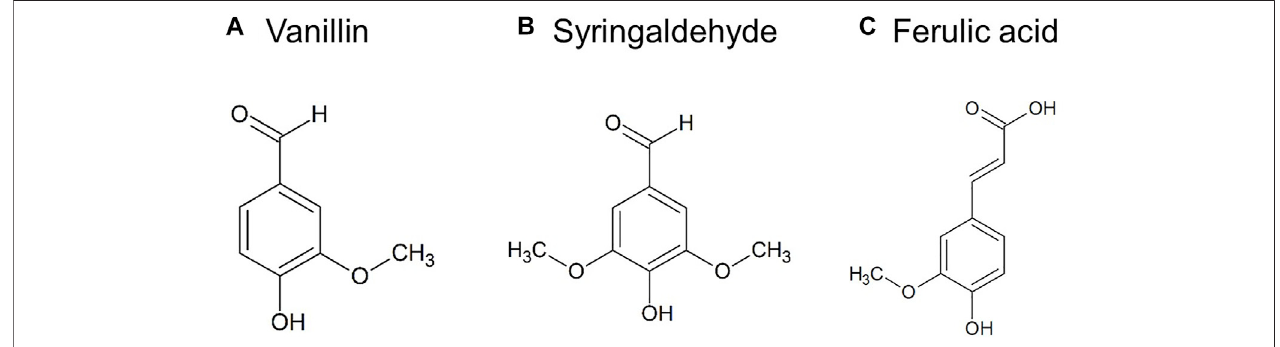
FIGURE 5 | Common low molecular weight aromatic chemical compounds produced by lignin depolymerization. (A) Vanillin, (B) Syringaldehyde, (C) Ferulic